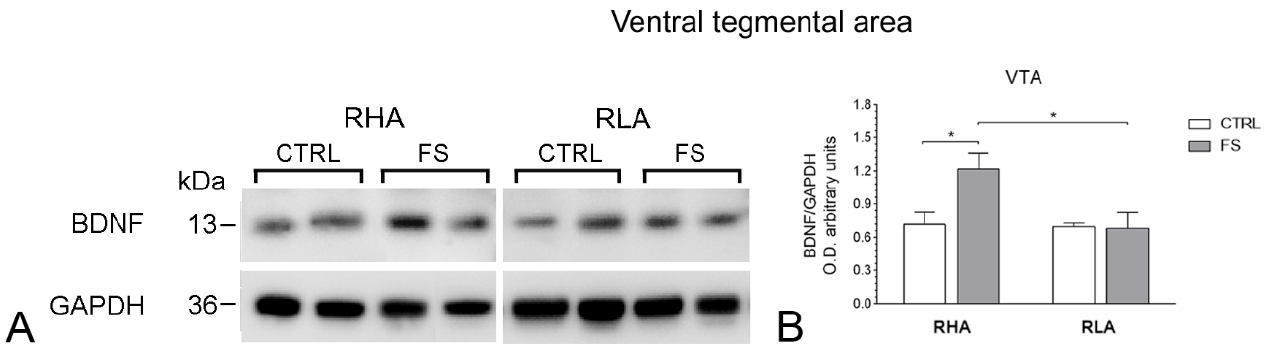
Figure 1. Western blot analysis of brain-derived neurotrophic factor (BDNF) protein levels in the ventral tegmental (VTA) area of RHA and RLA rats under baseline conditions (CTRL) and after a